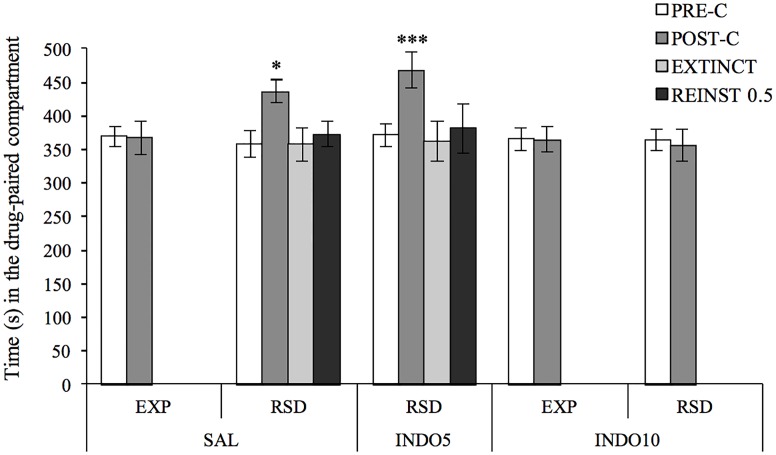
Administration of the highest indomethacin dose before each social defeat blocked acquisition of the CPP induced by 1 mg/kg of cocaine in defeated mice.Before the social stress protocol animals were randomly assigned to the following groups according to the pre-treatment they received: saline (EXP-SAL n = 13; RSD-SAL n = 14); 5 (RSD-INDO5 n = 16) or 10 mg/kg (EXP-INDO10 n = 13; RSD-INDO10 n = 17) of indomethacin. Bars represent the time (s) spent in the drug-paired compartment before conditioning sessions in the PRE-C test (white bars), after conditioning sessions in the POST-C test (dark grey bars), in the last extinction (EXTINCT) session (light gray bars), and in the reinstatement (REINST 0.5) test (black bars). Data presented as mean values ± SEM *p <0.05, ***p <0.001 significant difference in the time spent in the drug-paired compartment versus PRE-C.